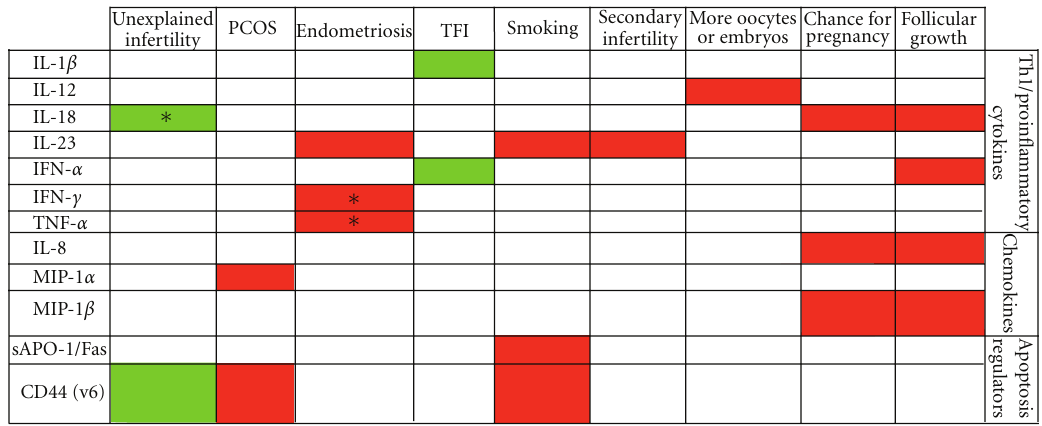
Figure 1: Associations between biomarkers and infertility parameters. Red boxes indicate positive association, green boxes negative association; empty boxes indicate no association found by adjusted regression analysis. Male factor infertility was chosen as a reference group, but in cases marked with ∗ . TFI was used as a reference. Abbreviations are as mentioned in the